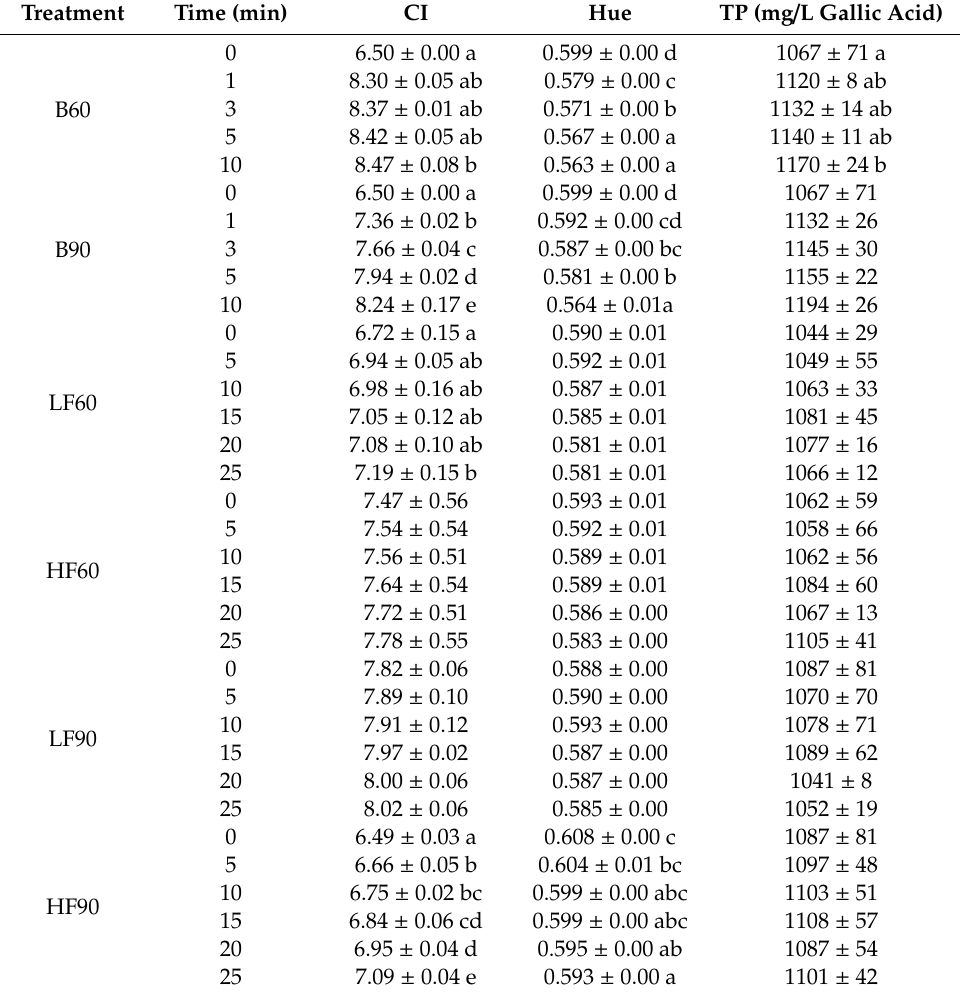
Table 3. Average color parameters assessed for wine with di ff erent Argon APCP treatment and the standard deviation of data ( n =